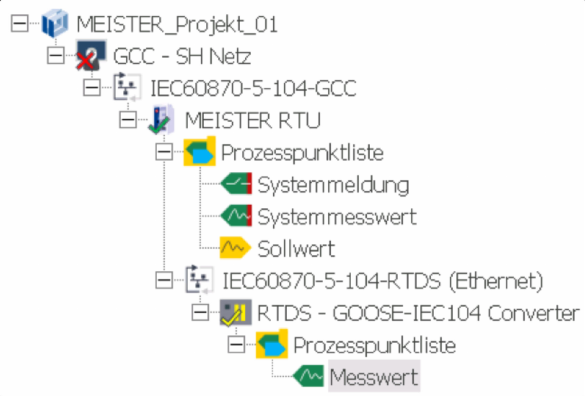
Figure 9. Communication tree structure SetIT.